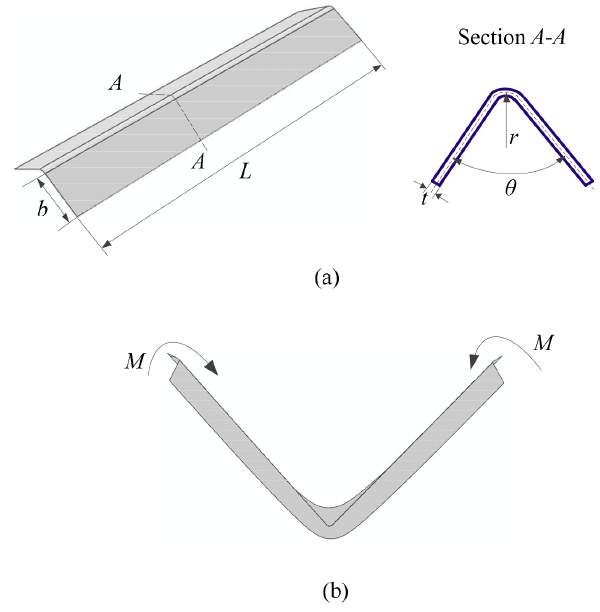
Figure 1. (a) The geometry of an undeformed creased strip and its cross-section and (b) localized fold at the middle of the creased strip by opposite-sense